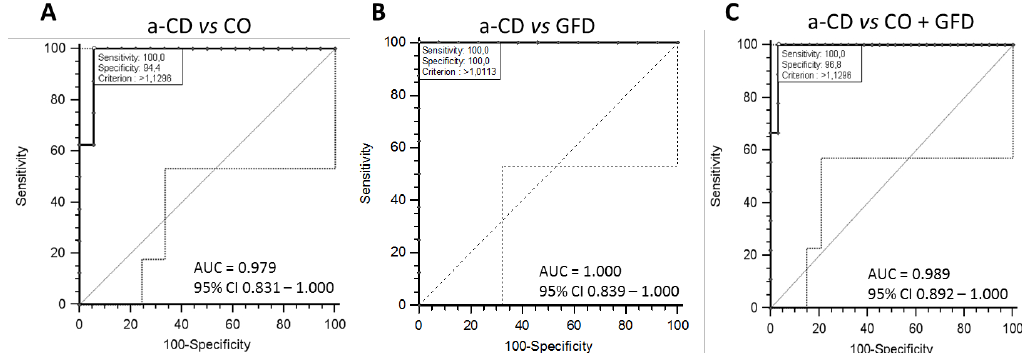
Figure 2. Receiver operation characteristic (ROC) curve of Neisseria spp. analysis using q-PCR data. First, we compared the active Celiac Disease (a-CD) vs. Control (CO) (panel A ) and a-CD vs. Gluten Free Diet (GFD) (panel B ), then we compared a-CD vs. CO + GFD (panel C ). MedCalc software was used to develop the receiver operating curve (ROC). The ROC curve is indicated with bold line and open circle represents the criterion point (threshold: ng / µ L). Dotted line indicates the 95% confidence interval (CI). Light line indicates the bisector. AUC, area under